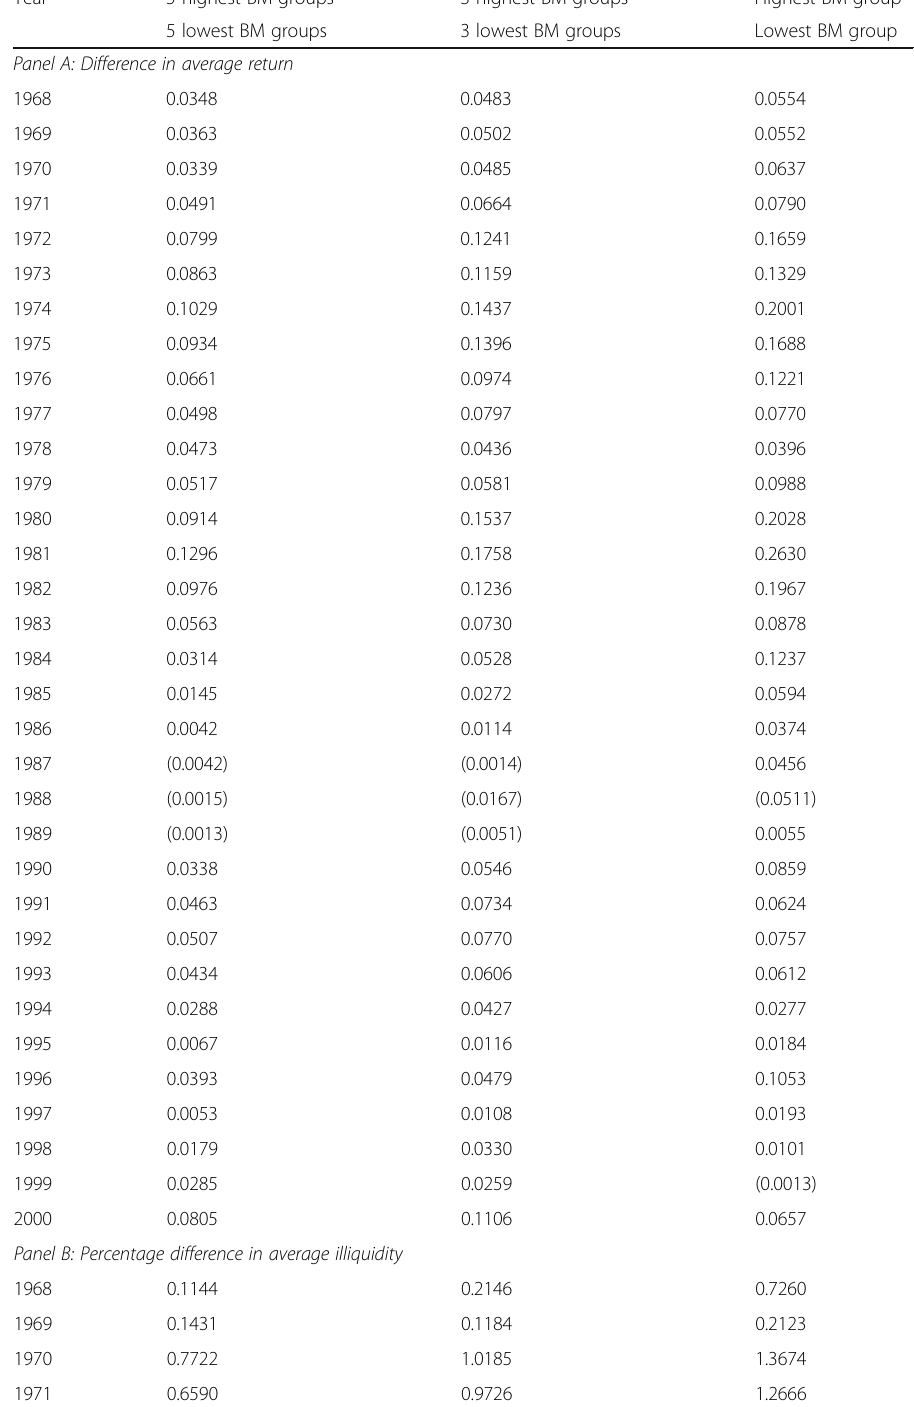
Table 4 Annual differences in average return and illiquidity for value and glamour portfolios. The difference in average return and the percentage difference in illiquidity is reported for each year in the sample period 1968 – 2000. The average return value is the annual average return over the 5 year post-portfolio formation period. The average illiquidity value is the annual average normalized illiquidity over the 5 year post-portfolio formation period. Both measures are reported for the difference between the five, three, and single highest and lowest BM